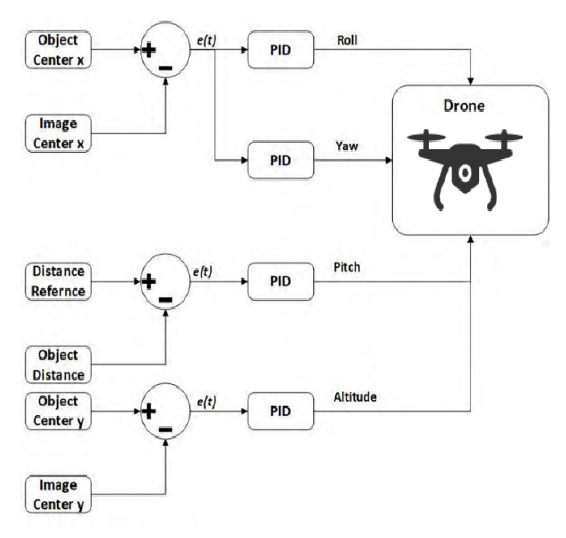
Figure 11. Diagram of the control scheme for detected object tracking.